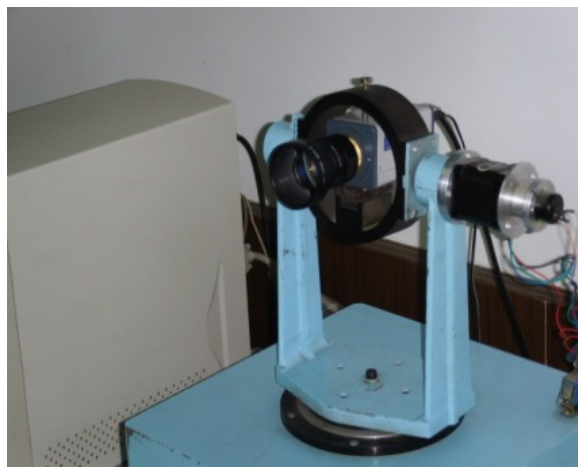
Figure 4. 2D turntable and video camera.